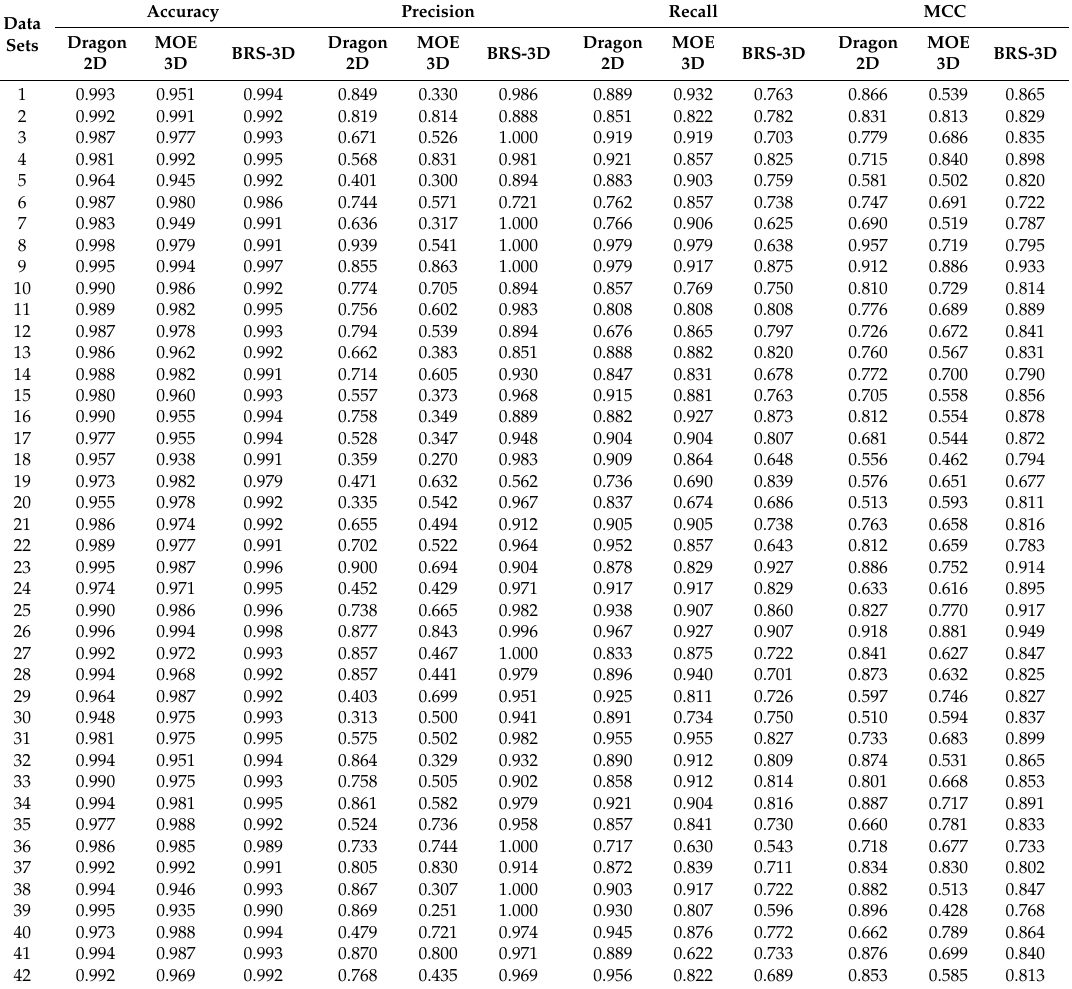
Table 2. SVM models based on Dragon 2D, MOE 3D, and BRS-3D